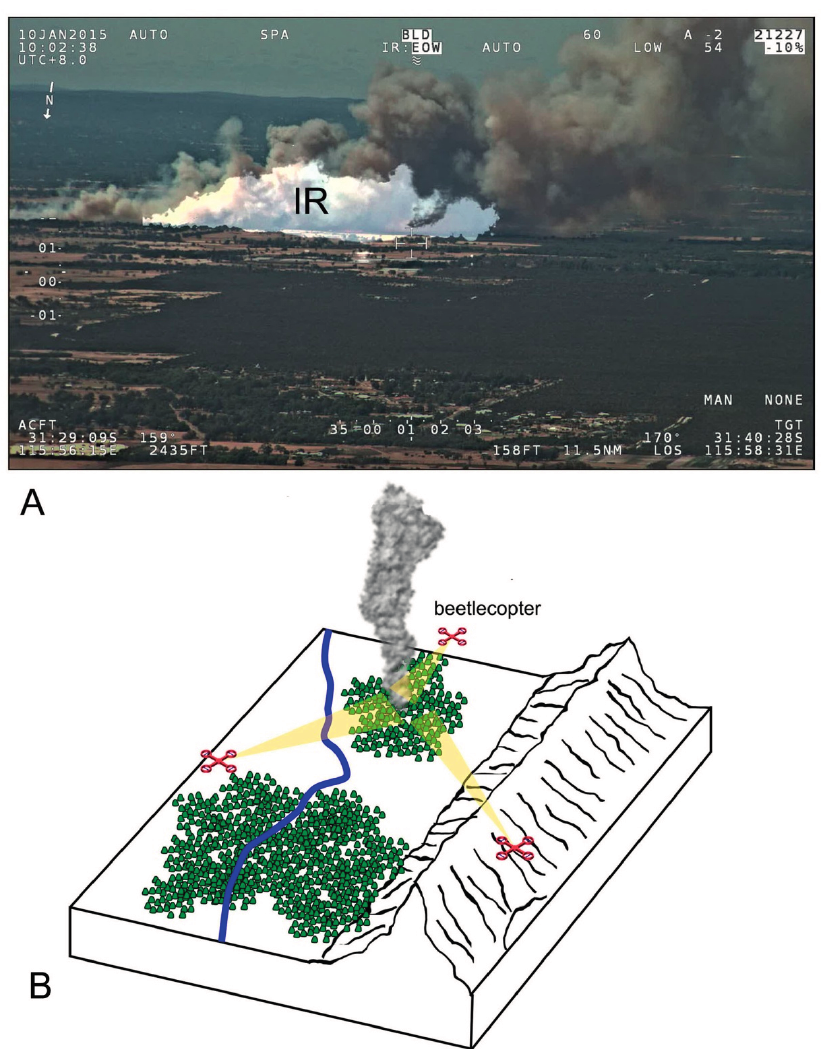
Figure 19. ( A ) Image of a large forest fire taken from a helicopter from a distance of 21 km with a WESCAM MX-15 in Western Australia. The image consists of two superimposed pictures: one taken with a high-resolution video camera and one taken with an infrared (IR) camera (white area “IR” showing the hot infrared emission zone of the ongoing fire). Image courtesy of Aerial Intelligence Unit of DEFS (see Acknowledgements). ( B ) Schematic drawing of three beetlecopter drones hovering over a terrain with a mountain range. From their stationary airborne positions drones identify a fire with on-board digital video and infrared cameras. By sending a set of alerting data to a central earth station the exact position and the current status of the fire can be